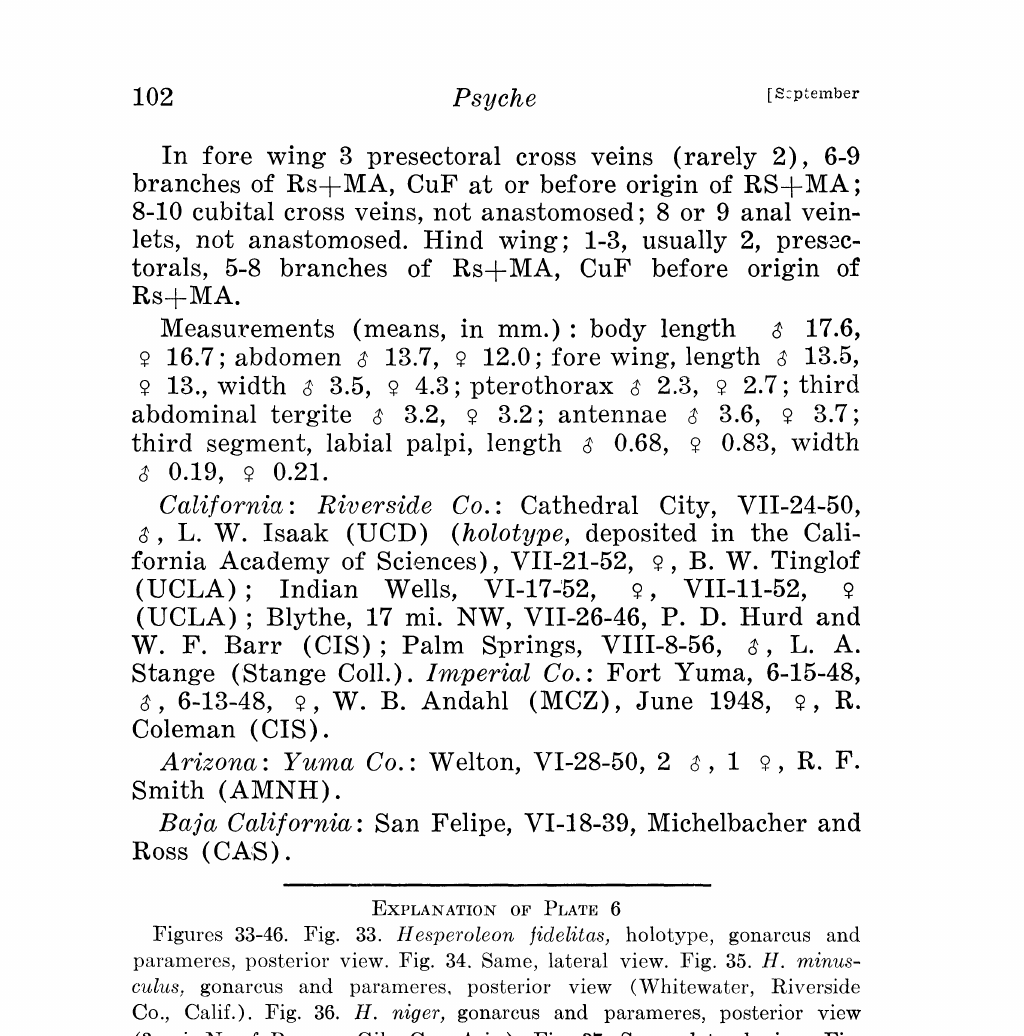
Fig. 40. Same, side view. Fig. 41. H. de]lexus, allotype, head. Fig. 42.. H. texanus, gonarcus and parameres, posterior view (sac inverted). (Mill Creek, San Bernardino Mrs.. ’Calif., 6000 ft.). Fig. 43. Same, lateral view. Fig. 44. H. in]uscatus, apex of abdomen, laterial view (Caion Pass, San Bernardino Co., Calif.). Fig. 45. Same, ventral view. Fig. 46. Scale for gonarcus and parameres